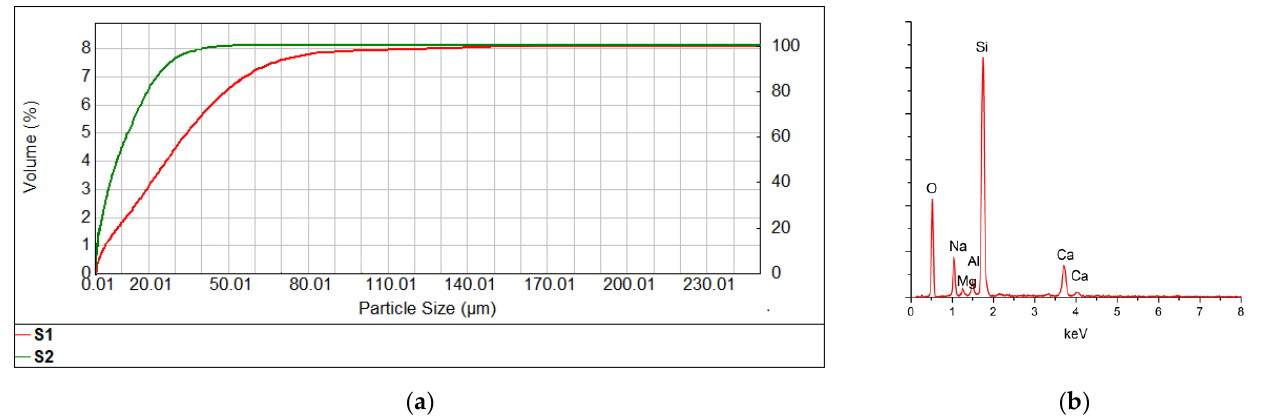
Figure 1. Particle size distribution ( a ) of S1 glass powder (red line) and S2 glass powder (green line) and EDS spectrum of glass powder ( b ).